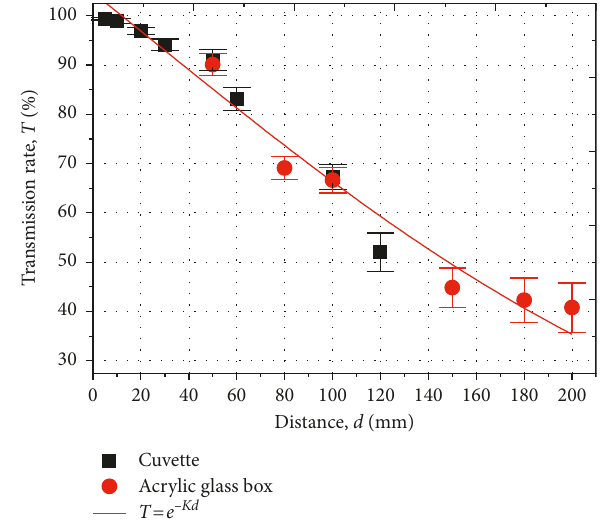
Figure 3: Relationship of transmittance T to viewing depth d .